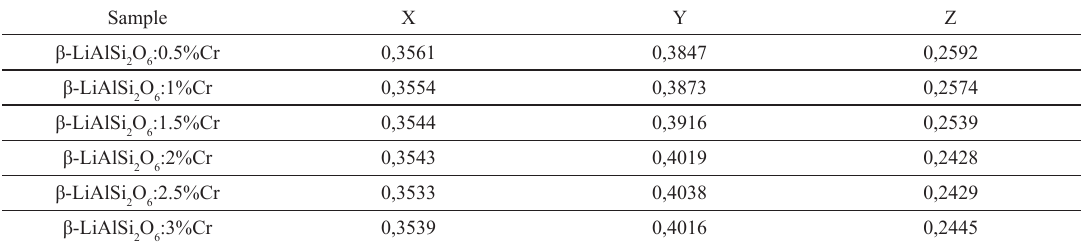
Table 2. CIE-XYZ (1931) colorimetric coordinates for β-LiAlSi